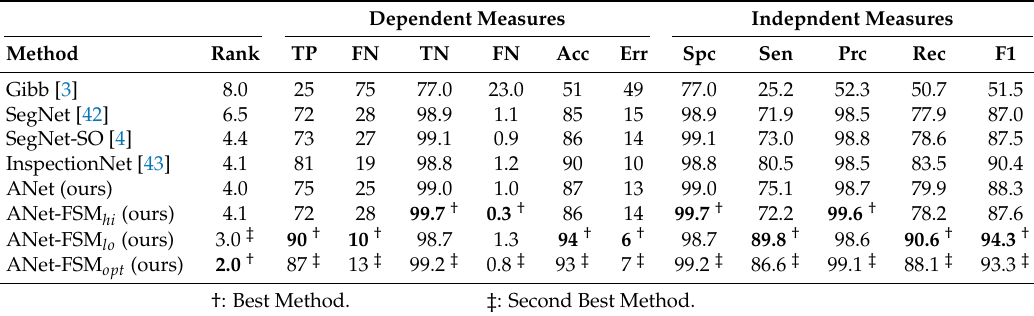
Table 6. Overall ranking of each method based on quantitative